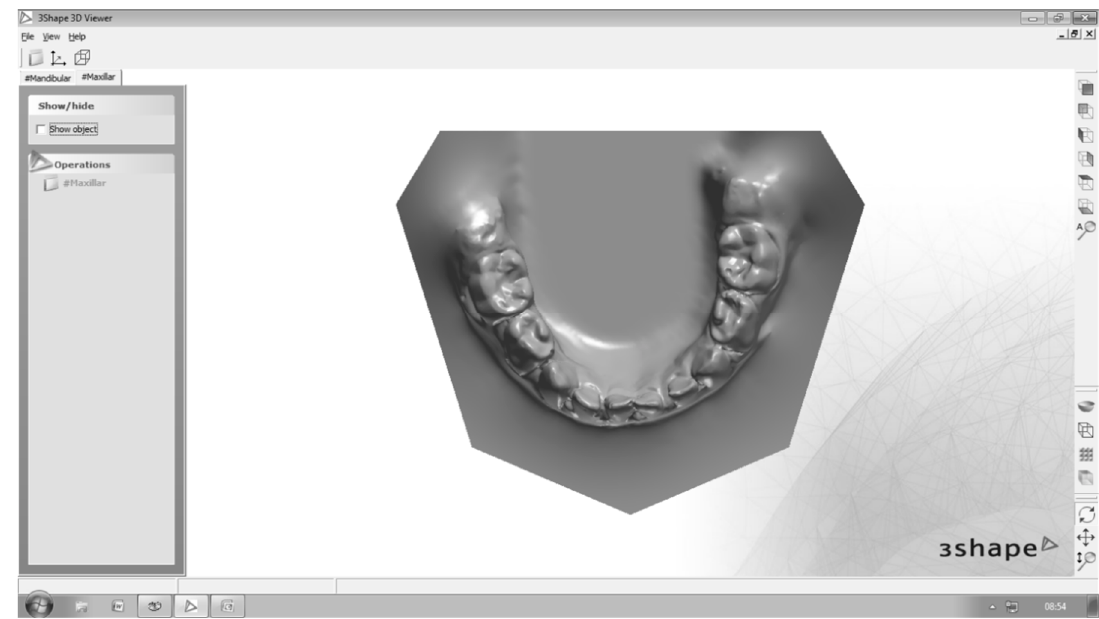
Figure 5. Lower view of digital model.